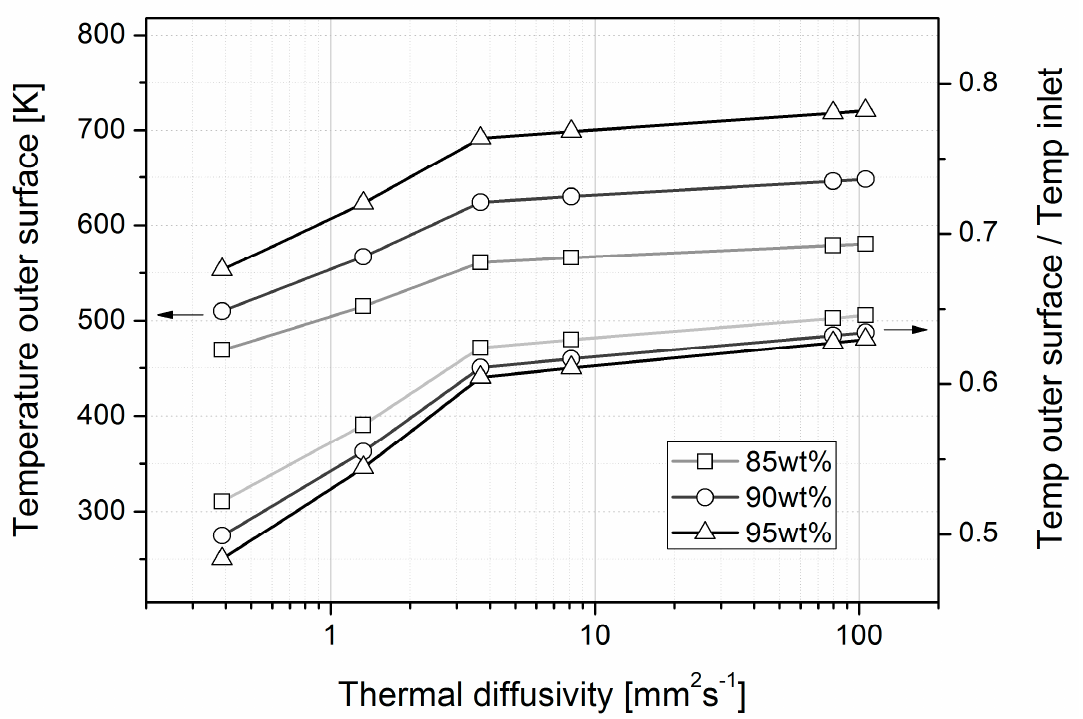
Figure 8. Comparison of the average temperature on the outside surface and that inside the chamber inlet of the microthruster with materials of various levels of thermal diffusivity and different propellant enthalpies (85, 90, and 95 wt% hydrogen peroxide).